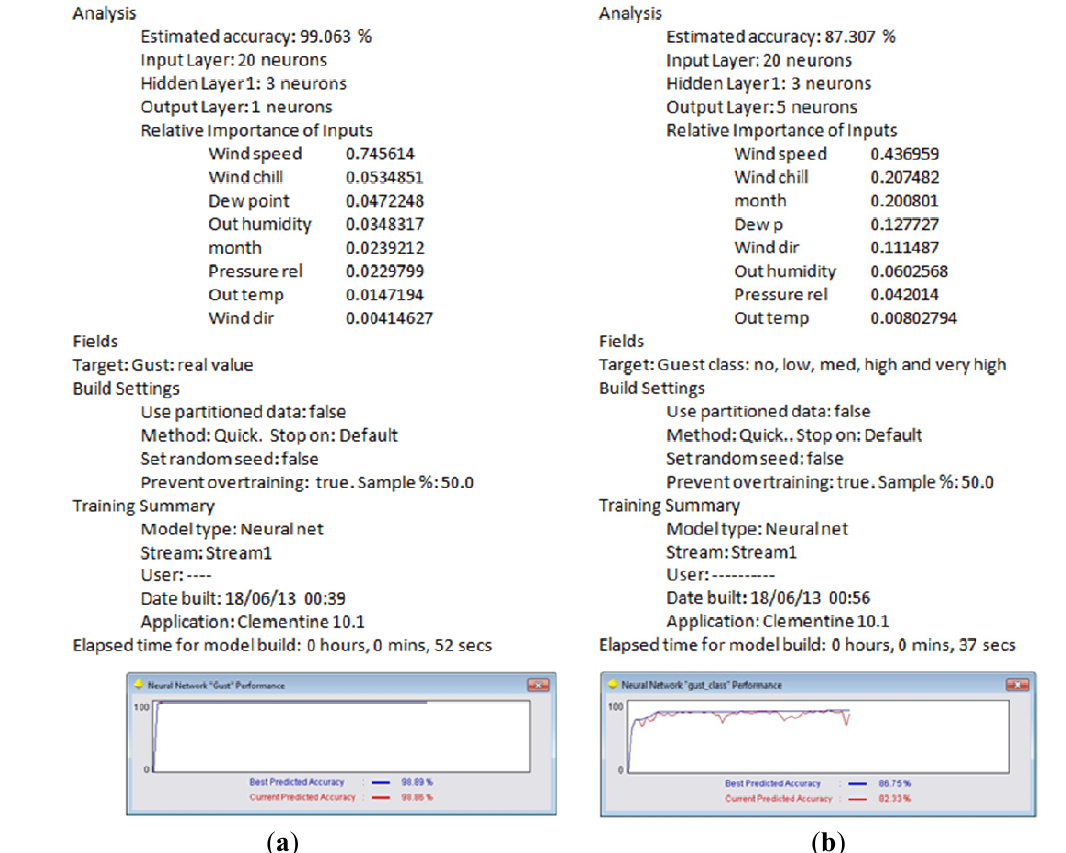
Figure 9. ( a ) Artificial Neural Network (ANN) predictions for real gust (over 99% accuracy) and ( b ) for gust classes (over 85% accuracy). Based on the results, more accurate real gust predictions depend on wind speed 74% and for gust class predictions, it is around